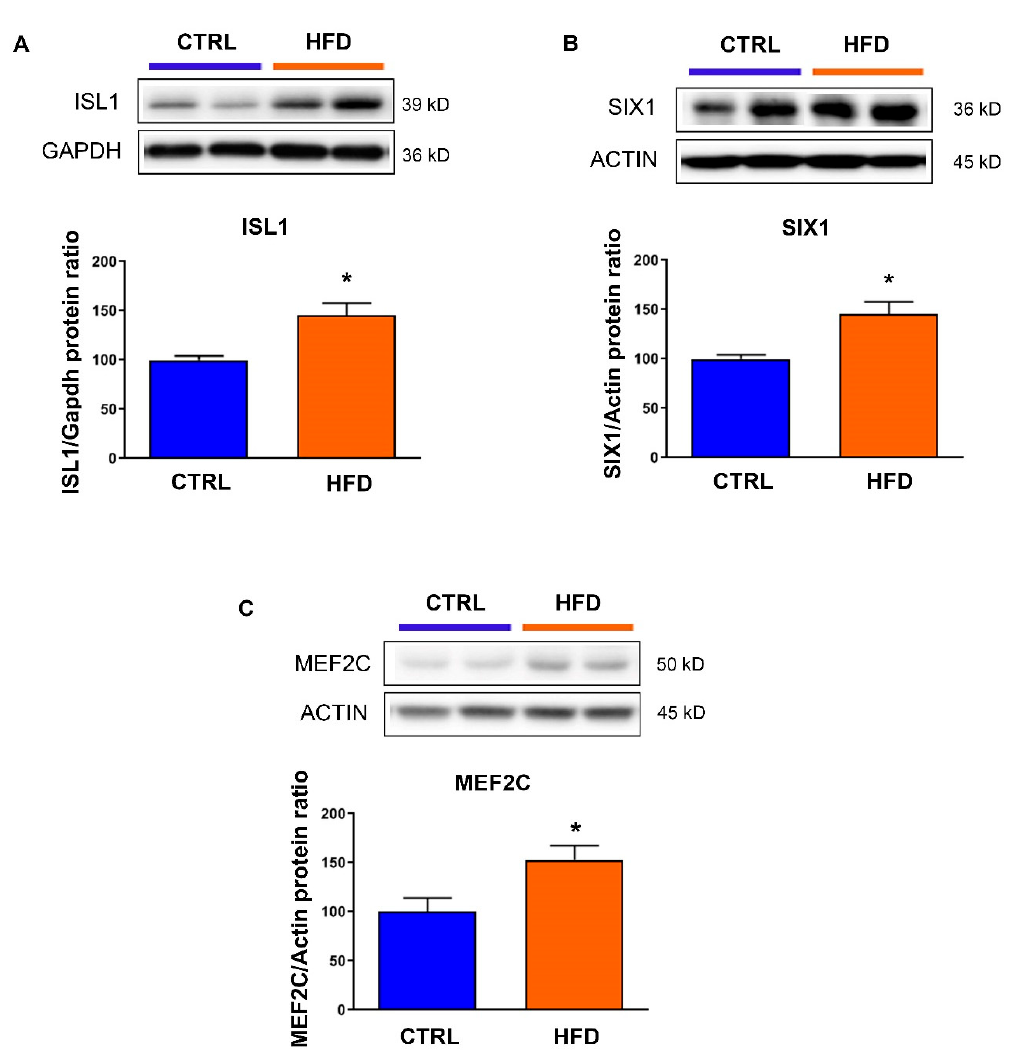
Figure 3. Protein levels of ( A ) isl lim homeobox 1 (ISL1), ( B ) six homeobox 1 (SIX1) and ( C ) mads box transcription enhancer factor 2, polypeptide C (MEF2C) were analyzed in the heart from male rat at postnatal day 77 under control chow diet (CTRL) or high-fat diet (HFD). Representative immunoblot image is presented for each protein. Data are expressed as the mean ± SEM; n = 13 per group. * p < 0.05 compared to control.